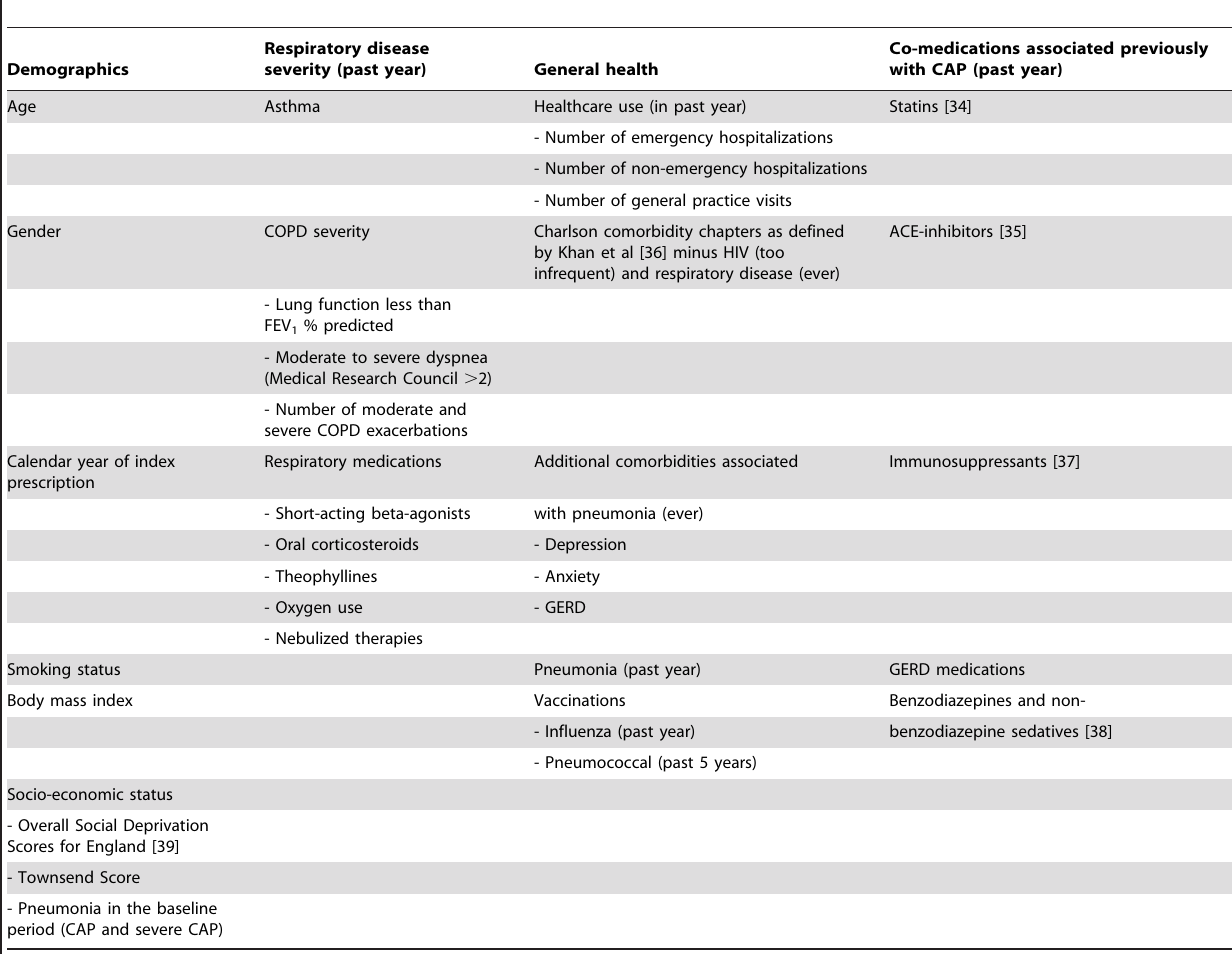
Table 1. Summary of Confounding Variables, by Category, Measured Prior to Index Prescription and by which Propensity Scores were